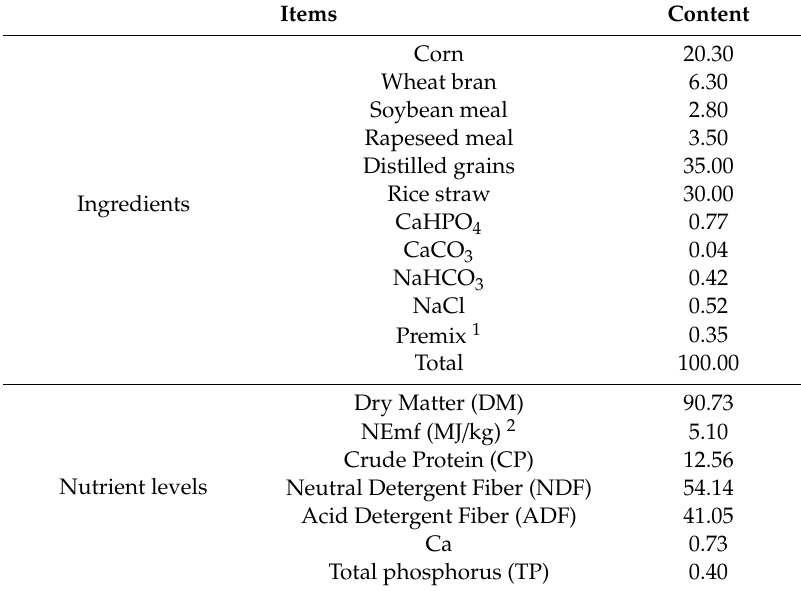
Table 1. Composition and nutrient levels of the experimental diet (air-dry basis, %).